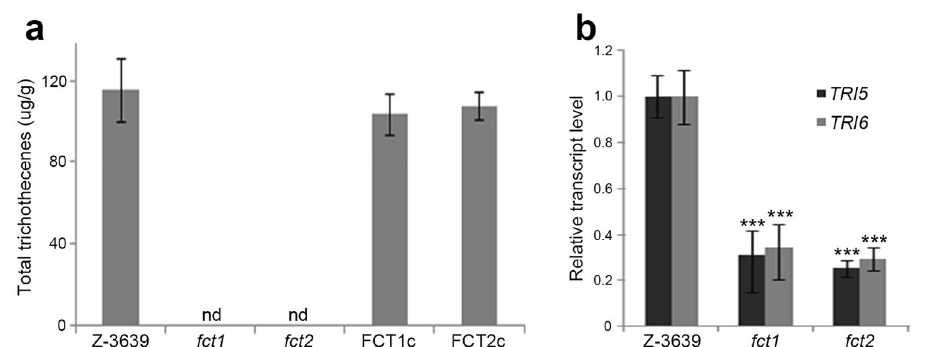
Figure 5. Trichothecene production by the F. graminearum strains. ( a ) Total trichothecene production. Each strain was grown in minimal medium containing 5 mM agmatine (MMA) for 7 days. Trichothecenes were analysed via gas chromatography-mass spectrometry (GC-MS) and quantified based on the biomass of each strain. ( b ) Transcript levels of TRI5 and TRI6 in the F. graminearum strains. The transcript levels were analysed via quantitative real-time PCR (qRT-PCR) 4 days after inoculation in MMA. Asterisks represent significant differences in the relative transcript levels of TRI5 and TRI6 between the wild-type strain and each mutant (p <